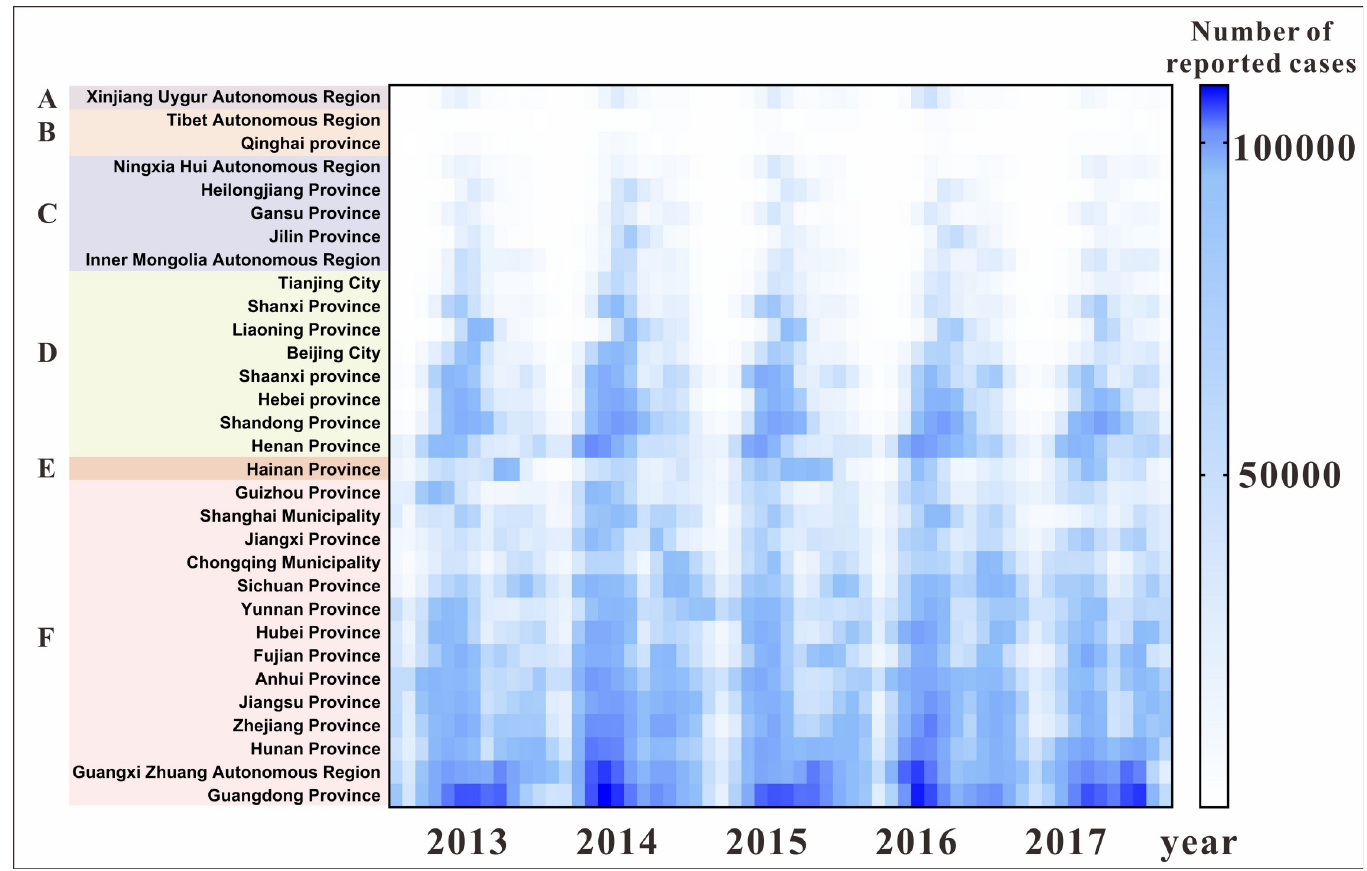
Fig 3. Distribution of Hand, Foot and Mouth Disease in Six Temperature Zones in China. (A: Mixer Zone; B: Plateau Zone; C: Middle Temperature Zone; D: Warm Temperature Zone; E: Subtropical Zone; F: Tropical